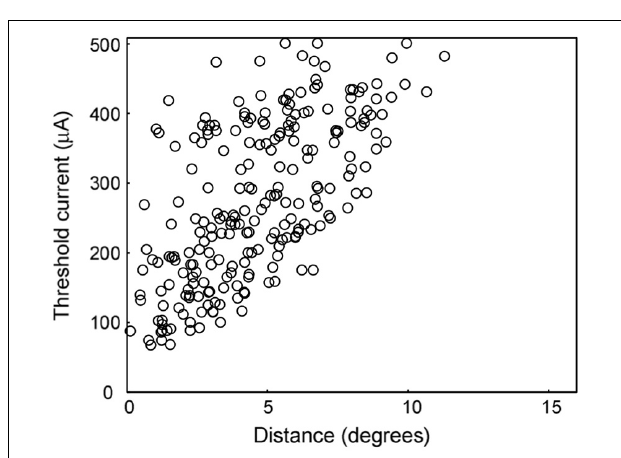
FIGURE 3 | Threshold current intensity for 50% response probability. The distribution of this measure is shown for the distances between the RF center and the stimulating electrode. As the distance decreased, the threshold current tended to